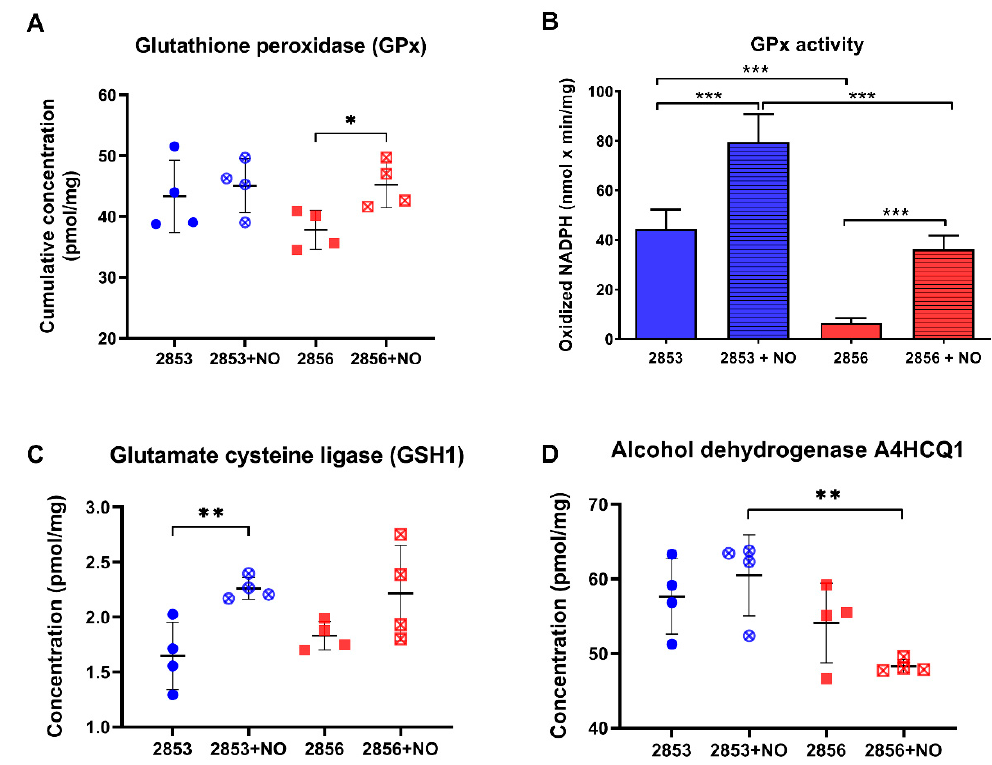
Figure 5. The NO-resistant strain increases glutathione metabolism enzymes in response to • NO challenge. ( A ) Cumulative concentration of all glutathione peroxidases (GPx) identified in our dataset. Each symbol shows the total sum of the GPx concentration values in each of the four biological replicates. ( B ) GPx activity was measured in parasite homogenates. ( C ) Absolute concentration of glutamate cysteine ligase (GSH1) in each strain. ( D ) Absolute concentration of alcohol dehydrogenase A4HCQ1 in each strain. Graphs represent mean ± SD of four independent experiments. Statistical differences by Student’s t test (* p < 0.05; ** p < 0.01; *** p < 0.001). 2853: NO-resistant strain; 2853+NO: NO-resistant strain challenged with 1 / 5 IC 50 /4h NaNO 2 ; 2856: NO-susceptible strain; and 2856+NO: NO-susceptible strain challenged with 1 / 5 IC 50 /4h NaNO 2 .